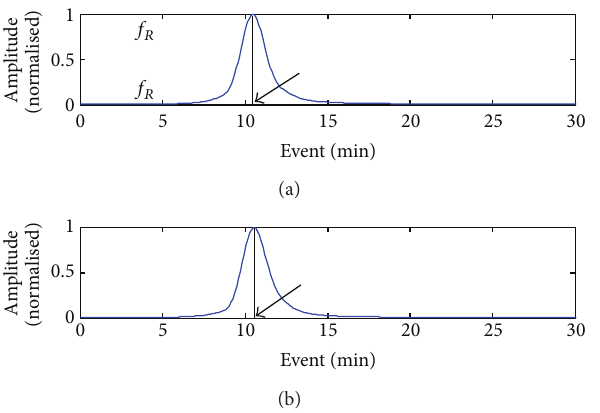
Figure 4: (a) Power spectrum of 𝑆 11 phase signal (same data of Figure 2). (b) Power spectrum of the displacement signal measured by the LDVi (same data of Figure 3).